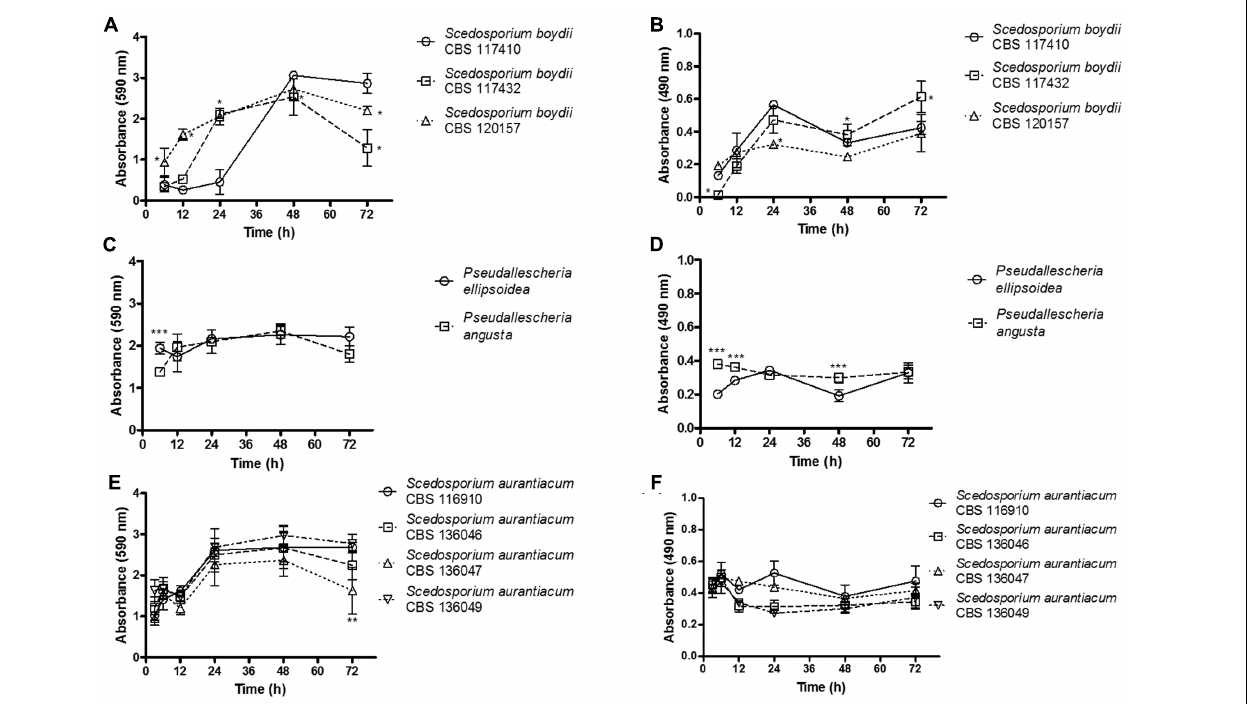
FIGURE 1 | The kinetics of biofilm formation was evaluated using biomass and metabolic assays. Biofilm formation was monitored and quantified using two complementary methods at selected time points (3, 6, 12, 24, 48, and 72 h). The graphs (A,C,E) shown demonstrate the total biomass of the biofilms. The results were quantified using a crystal violet assay. The graphs shown in (B,D,F) demonstrate the metabolic activity of the cells inside the biofilms. The results were quantified using XTT-reduction assays. Statistical differences ( P < 0.05) are represented by asterisks. ∗ Statistical difference when S. boydii CBS 117410 was used as a